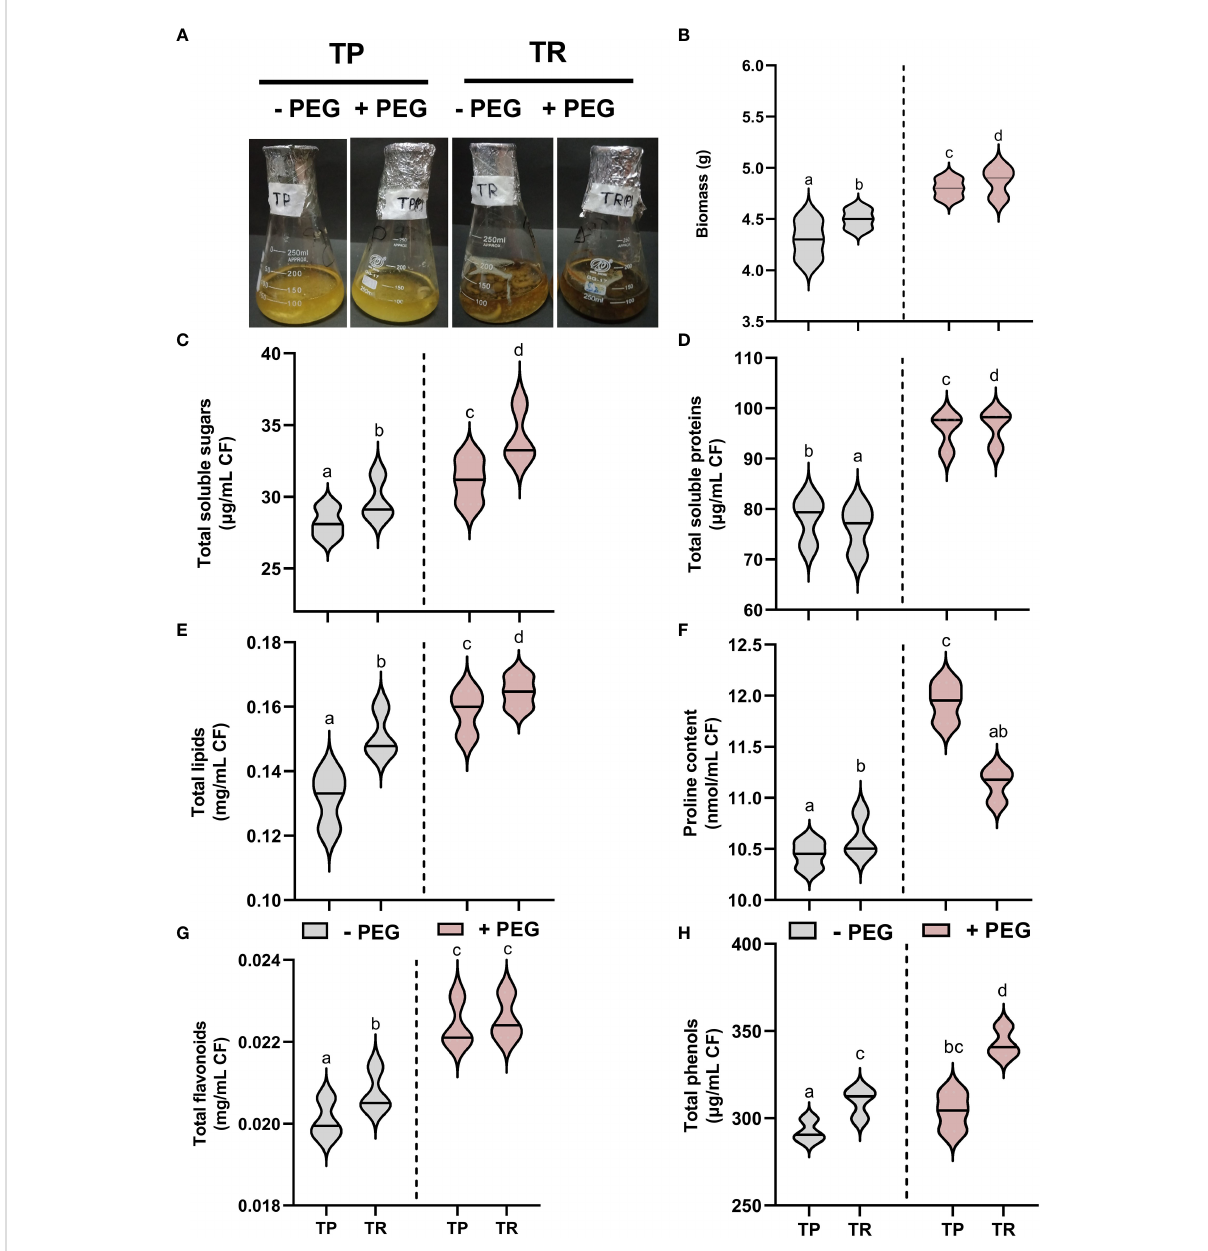
FIGURE 2 Endophytic fungal (TP and TR) characterization. (A) Screening of fungal strains (TP and TR) for PEG-induced drought stress tolerance, (B) Biomass, (C) Total soluble sugars, (D) Total soluble proteins, (E) Total lipids, (F) Proline content, (G) Total fl avonoids, and (H) Total phenols, measured in CF of TP and TR isolates. Quantitative data is representing the means ± SE values of at least three independent biological replications. Various letters have been presented to show the statistical differences at signi fi cance level of p¾ 0.05 using Duncan ’ s Multiple Range Test (DMRT). CF, Culture